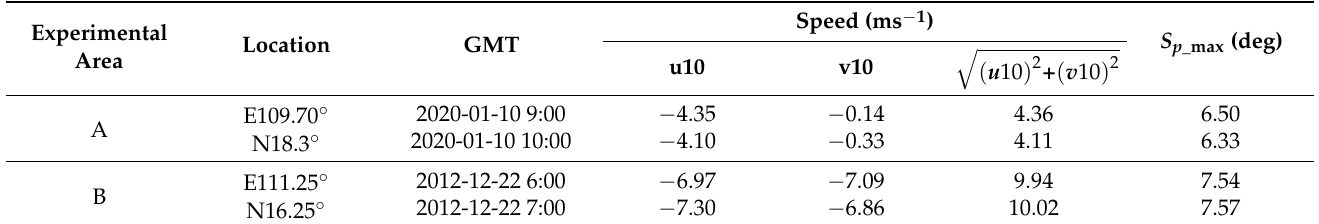
Table 10. The 10-m wind speeds and the probability extremum S p _max in two experimental areas. Experimental